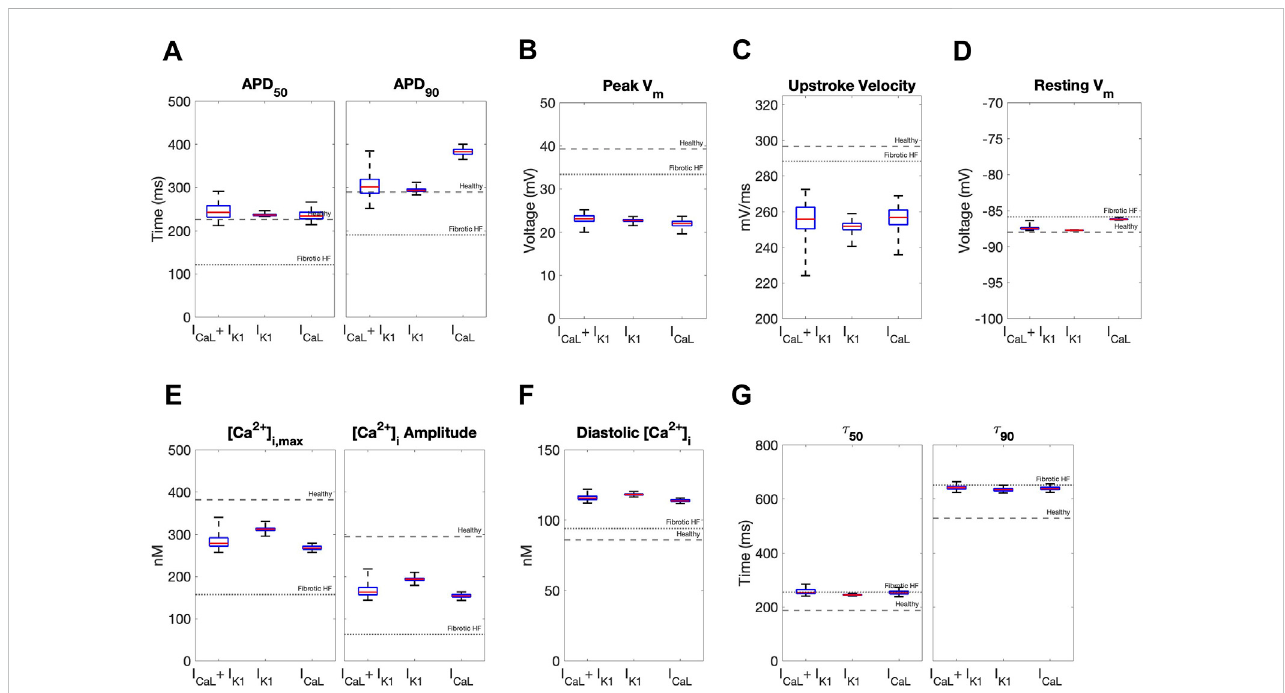
FIGURE 5 Effectsofacceptedcustomcellheterocellularcouplingon fi broticheartfailurecardiomyocyteelectrophysiologyandcalciumhandling.Actionpotential and calcium transient metrics are shown as box and whisker plots for coupling fi brotic heart failure (HF) cardiomyocytes to accepted custom cells with cardiomyocyte L-type calcium channel (I CaL ), inward recti fi er channel (I K1 ), or both (I CaL + I K1 ). Action potential metrics include: (A) Action potential duration (APD)at50%repolarization(APD 50 )and90%repolarization(APD 90 ); (B) peakvoltage; (C) upstrokevelocity;and (D) restingmembranepotential.Calcium transientmetricsinclude: (E) peakintracellularcalciumandcalciumtransientamplitude; (F) diastoliccalcium;and (G) calciumrelaxationtimeconstantat50% decay ( τ 50 ) and 90% decay ( τ 90 ). Values for healthy and untreated fi brotic HF cardiomyocytes are shown as dashed and dotted lines,